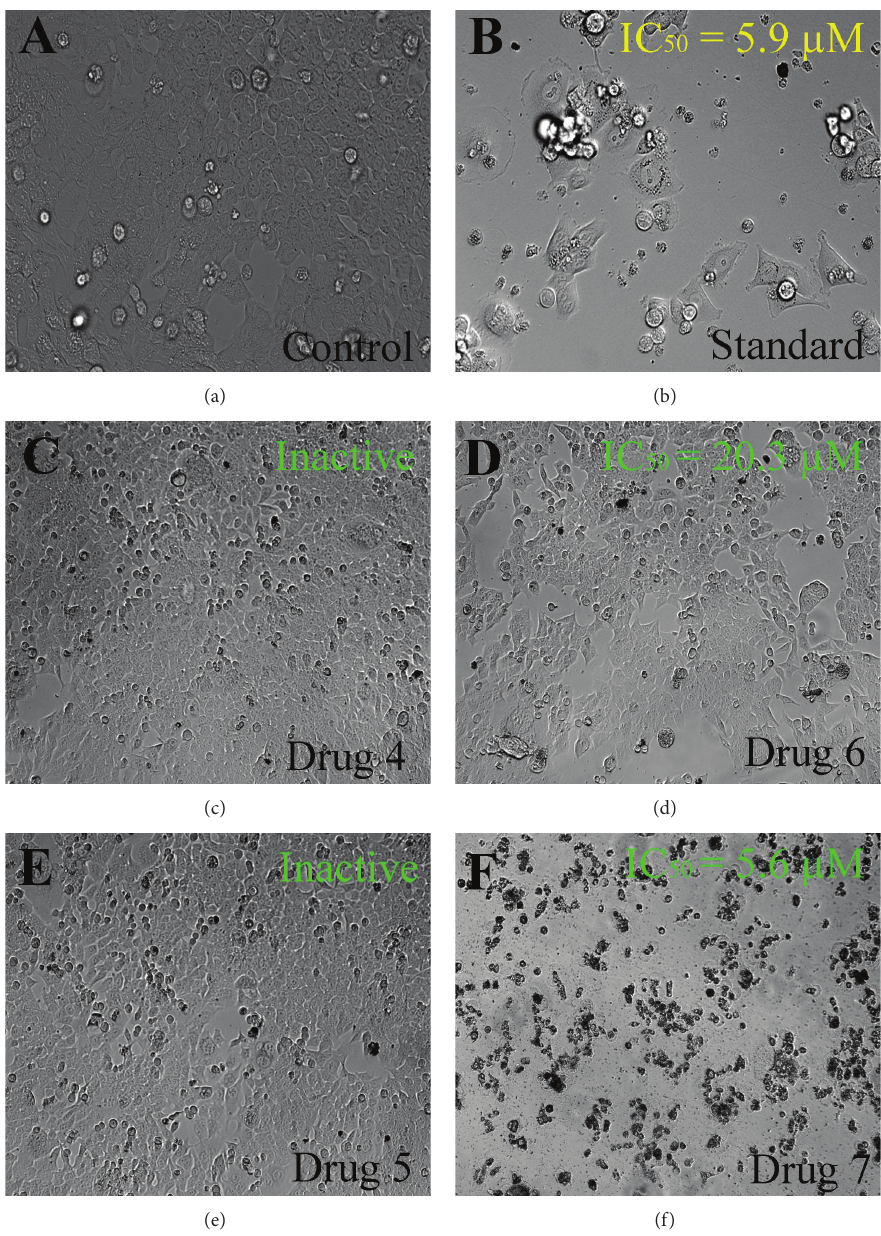
Figure 6: HCT 116 cell images were taken under an inverted phase-contrast microscope at × 200 magnification with a digital camera at 48 hours after treatment with the samples. (a) Cells from the control group showed fully confluent growth with compactly proliferating HCT 116 cells. (b) Cells treated with the standard drug 5-fluorouracil (IC 50 = 5.9 𝜇 M) showed decreased viability. The cells show apoptotic characteristic features as the cell membrane blebbing, and nuclear condensation can be seen in the treated cells. (c) Treatment with 4 showed negligible cytotoxicity (IC 50 > 200 𝜇 M), as the cell growth did not get affected, and cellular morphology was almost similar to that of negative control. (d) HCT 116 cells treated with the compound 6 exhibited significant antiproliferative activity (IC 50 = 20.3 𝜇 M). As the photomicrograph depicts the treatment of HCT 116 cells with the 6 reduced the doubling time of cells drastically, the population of cells decreased significantly when compared to the negative control. (e) Treatment with 5 showed insignificant inhibitory effect on proliferation of cells (IC 50 > 200 𝜇 M), as the growth and morphology of the cells were unaltered with respect to those of negative control. (f) Photomicrograph of the cells treated with 7 shows the strong cytotoxic effect on HCT 116 cells (IC 50 = 5.6 𝜇 M). The effect can be compared with the standard reference, 5-fluorouracil. The treatment affected the morphology of almost all cells as the cells lost their pseudopodial like cellular